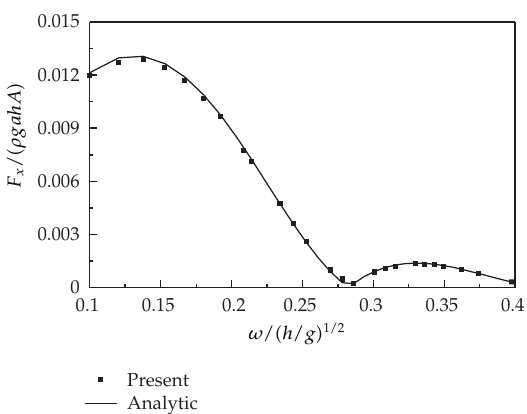
Figure 6: Horizontal wave force on cylinder.